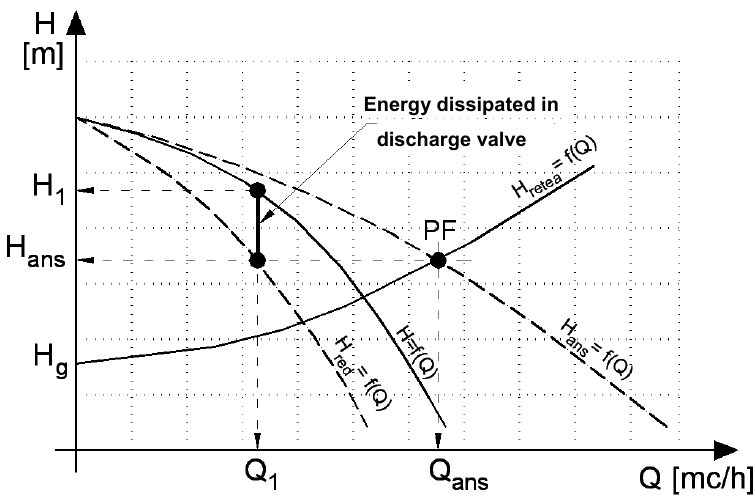
Figure 2. Operating sequence for a pumping stations with variable speed.